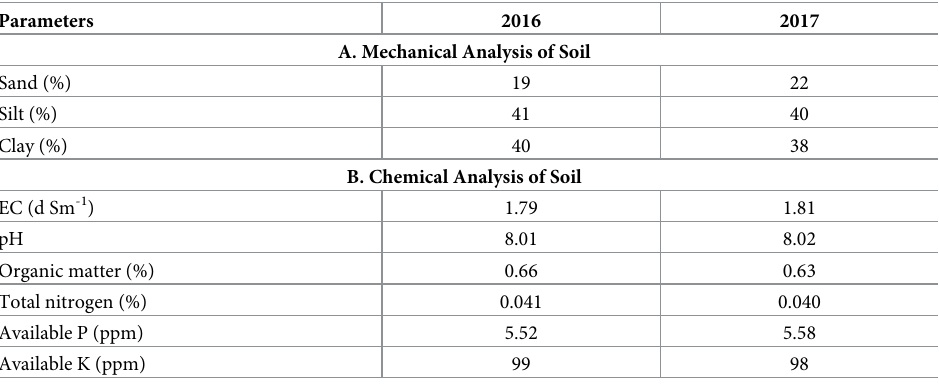
Table 1. Physico-chemical analysis of experimental soil (on dry weight basis).